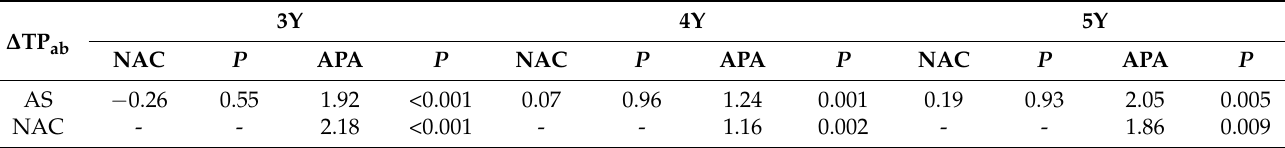
Figure 6. The translucency of zirconia ceramics (3Y, 4Y, 5Y) in 1 mm thickness. Table 3. ∆ TP ab —observed mean differences of TP between different types of surface treatment. Letter P denotes the level of significance ( P